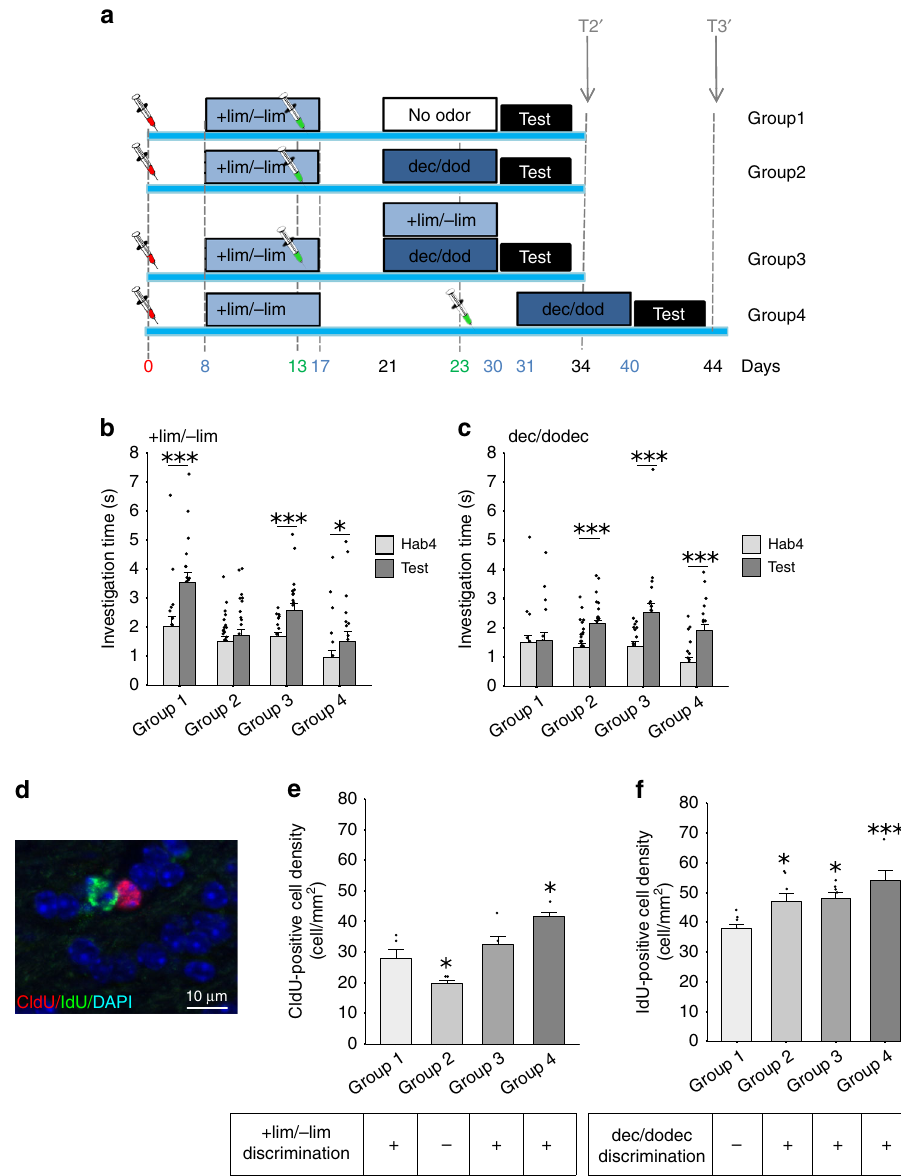
Fig. 3 Reactivation of learned information prevented cell death and maintained memory. a Experimental design. b , c Behavioral results. b + lim and -lim are discriminated in groups 1 ( n = 18), 3 ( n = 20) and 4 ( n = 10) but not in group 2 ( n = 18). c Dec/dodec are discriminated in Group 2 ( n = 18), 3 ( n = 20) and 4 ( n = 10) but not in group 1 ( n = 18). d Example of CldU/DAPI and IdU/DAPI double labeling. e . Density of CldU-positive cells. A lower density is observed in group 2 compared to groups 1, 3, and 4 and a higher density in group 4 compared to groups 1, 2, and 3 ( n = 5/group). f Density of IdU-positive cells is higher in groups 2 ( n = 8), 3 ( n = 7) and 4 ( n = 5) compared to group 1 ( n = 8). Tukey corrected t -tests * p ≤ 0.05, *** p < 0.001. Data are represented as data points and mean ± sem. Source data are provided as a Source Data fi